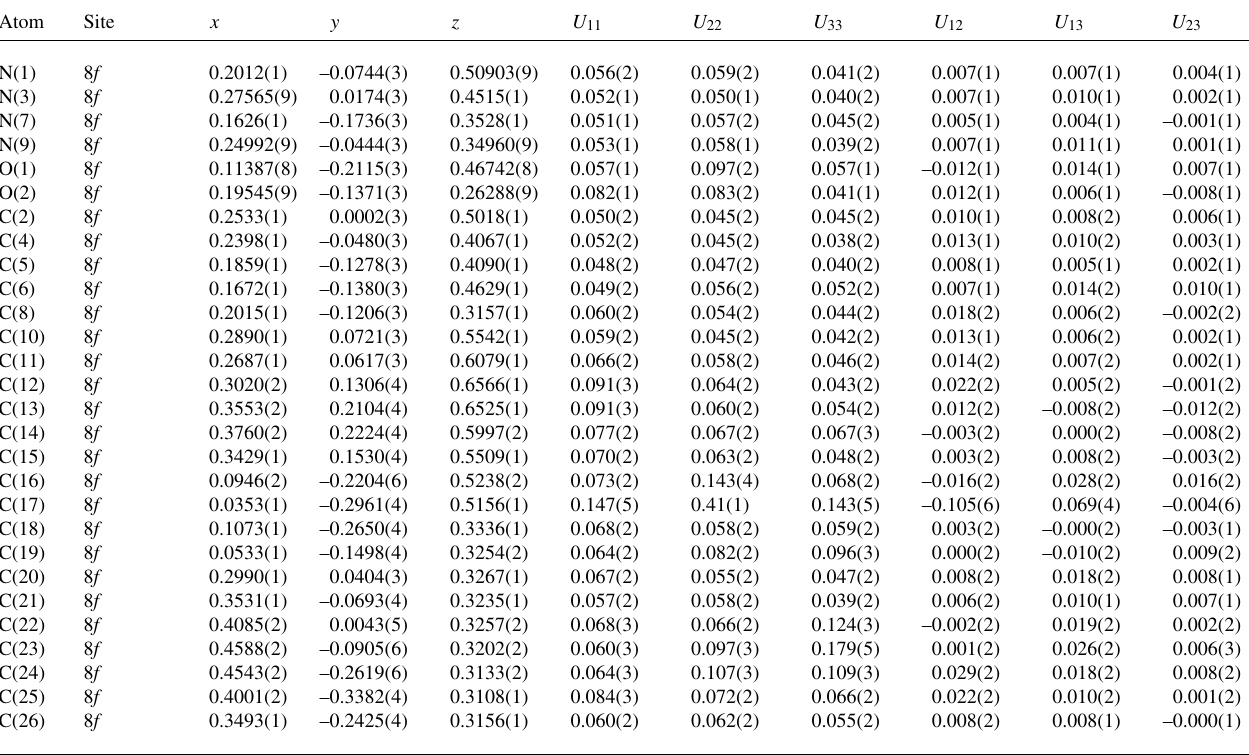
Table 3. Atomic coordinates and displacement parameters (in Å 2 ) .